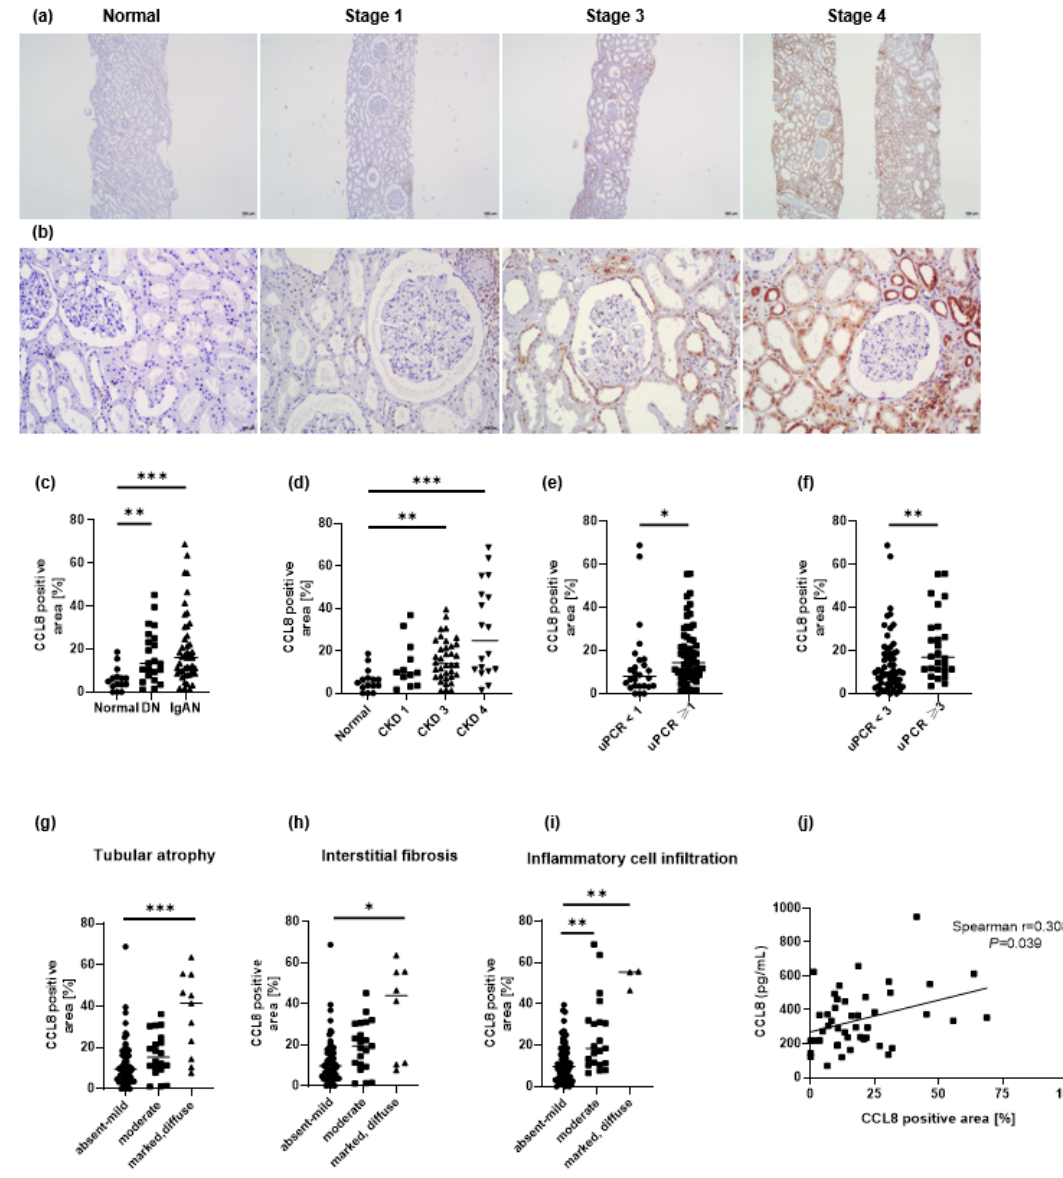
Figure 3. Representative photographs of kidney sections of healthy controls (HC), chronic kidney disease stage 1, 3, and 4 of IgA nephropathy (IgAN) patients (original magnifications, Panel ( a ), ×40 and ( b ), ×200). CCL8 immunohistochemical analysis in patients with IgAN showed that CCL8-positive cells were predominantly located in the periglomerular and inflamed tubulointerstitium ( a , b ). Quantification of CCL8-positive cells was performed by computer-based morphometric analysis. CCL8 expression were compared among patients with IgAN ( n = 46), diabetic nephropathy (DN, n = 22), and HC ( n = 15) ( c ), which correlated with kidney function at the time of biopsy. The expression of CCL8 increased significantly with advancing stages, especially in chronic kidney disease stage 3 and 4 ( d ). The level of CCL8 positive area was correlated with urine protein/creatinine ratio (uPCR) ( e , f ). CCL8 expressions were significantly higher in marked degree of tubular atrophy ( g ), interstitial fibrosis ( h ) and interstitial inflammation ( i ). In 45 patients who were examined for serum CCL8 and number of CCL8-positive cell simultaneously, serum CCL8 levels positively correlated with CCL8 expression levels from immunohistochemical analysis ( j ). * p < 0.05, ** p < 0.01, and *** p < 0.001.